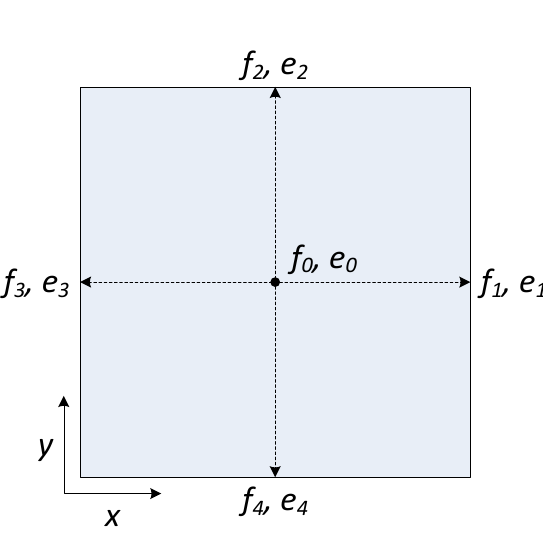
Figure 1. The D2Q5 Lattice Boltzmann Method (LBM)